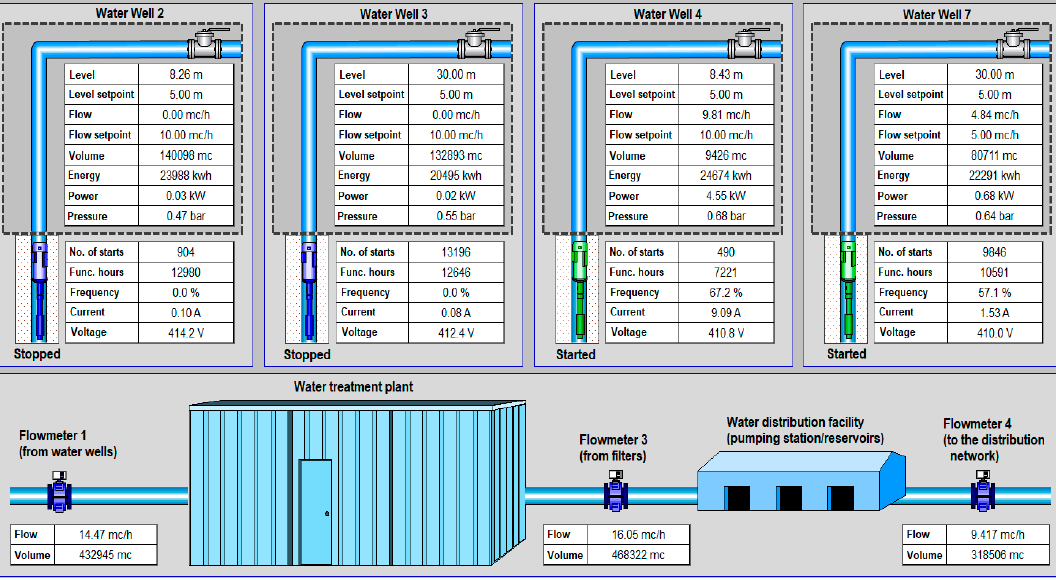
Figure 1. A drinking water facility (DWF).